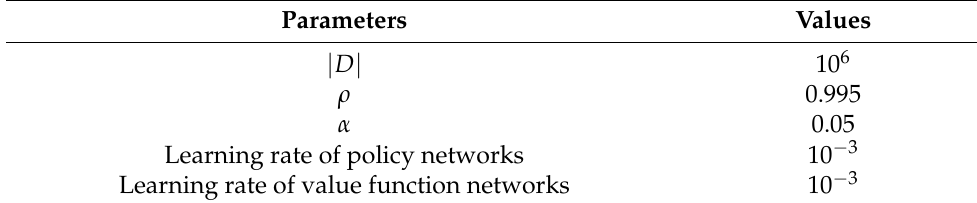
Table 4. Parameter settings of SAC.